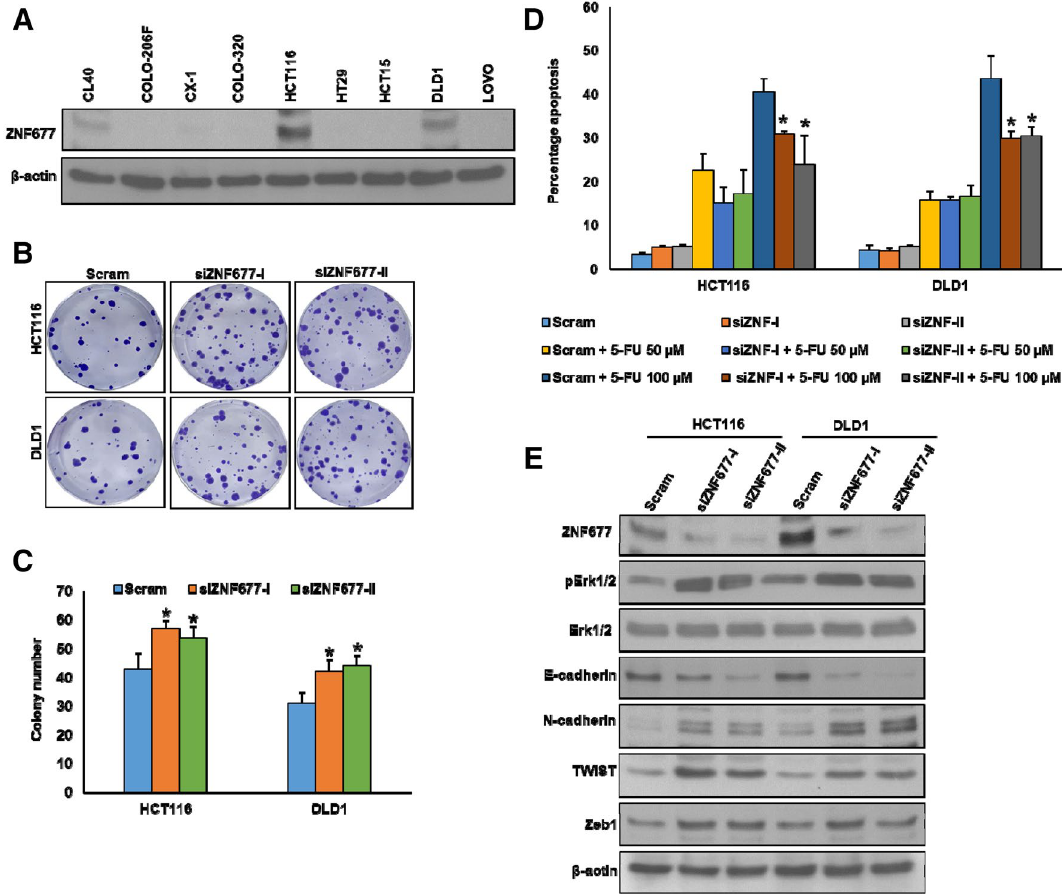
Figure 3. Knockdown of ZNF677 increases the chemoresistance in CRC cell lines. ( A ) Basal expression of ZNF677 in a panel of CRC cell lines. Proteins were isolated from nine CRC cell lines and immunoblotted with antibodies against ZNF677 and β-actin. ( B , C ) Knockdown of ZNF677 increases clonogenicity. CRC cells were transfected with scrambled siRNA and two different ZNF677 siRNA’s (20 nM). After 48 h, cells were seeded at a density of 500 cells per well in 6-well plate, and grown for an additional 10 days, then stained with crystal violet and colonies were counted (n = 3), * p < 0.05, compared to control. ( D ) Knockdown of ZNF677 increases the chemoresistance. CRC cells were transfected with either scrambled siRNA or two different ZNF677 siRNA’s (20 nM) and subsequently treated with 50 and 100 μM 5-fluorouracil (FU) for 48 h. Following treatment, cells were analysed for apoptosis by flow cytometry (n = 3), * p < 0.05, compared to respective 5-FU alone treated control. ( E ) Knockdown of ZNF677 increase the markers of cell survival and EMT progression. After transfection with ZNF677 siRNA’s, cells were immuno-blotted with antibodies against ZNF677, pERK1/2, ERK1/2, E-cadherin, N-cadherin, TWIST, Zeb1 and β-actin as